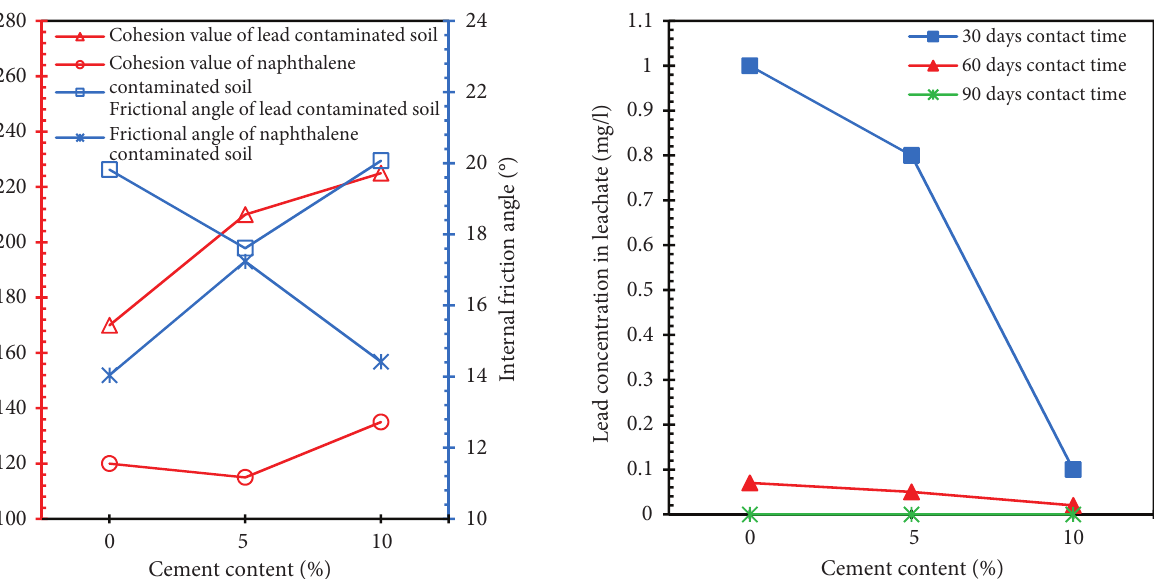
Figure 4. Variation of DS with binder content Figure 5. Leachate lead